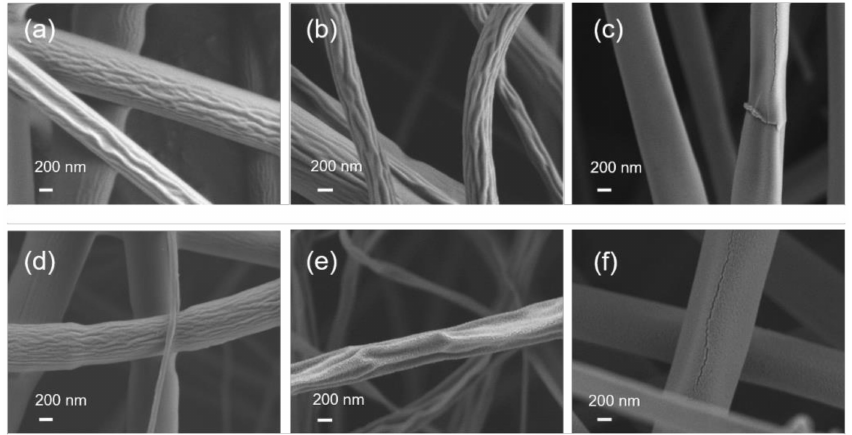
Figure 2. SEM micrographs of CA fibres ( a ) before ALD or, ( b ) with 2 nm Al 2 O 3 , ( c ) 30 nm Al 2 O 3 ,